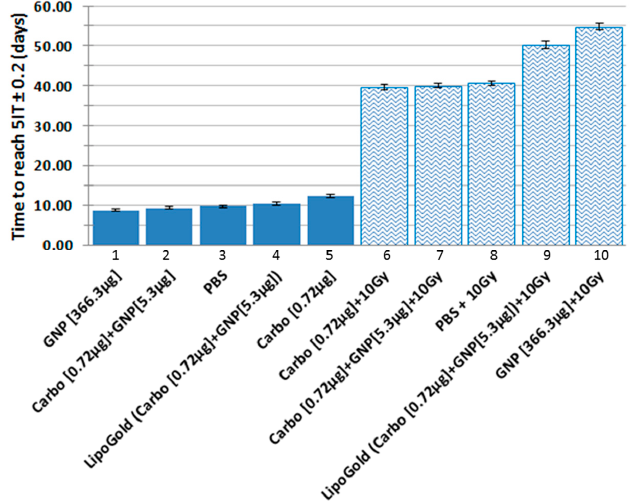
Figure 3. Time to reach five times the initial volume (5IT) after different treatments of Nu/Nu nude mice bearing a subcutaneous HCT116 colorectal cancer cell line. Data from the pink horizontal trace in Figure 2. The SD represent the surviving time passing through the pink line (5IT ± 0.2) of Figure 2.